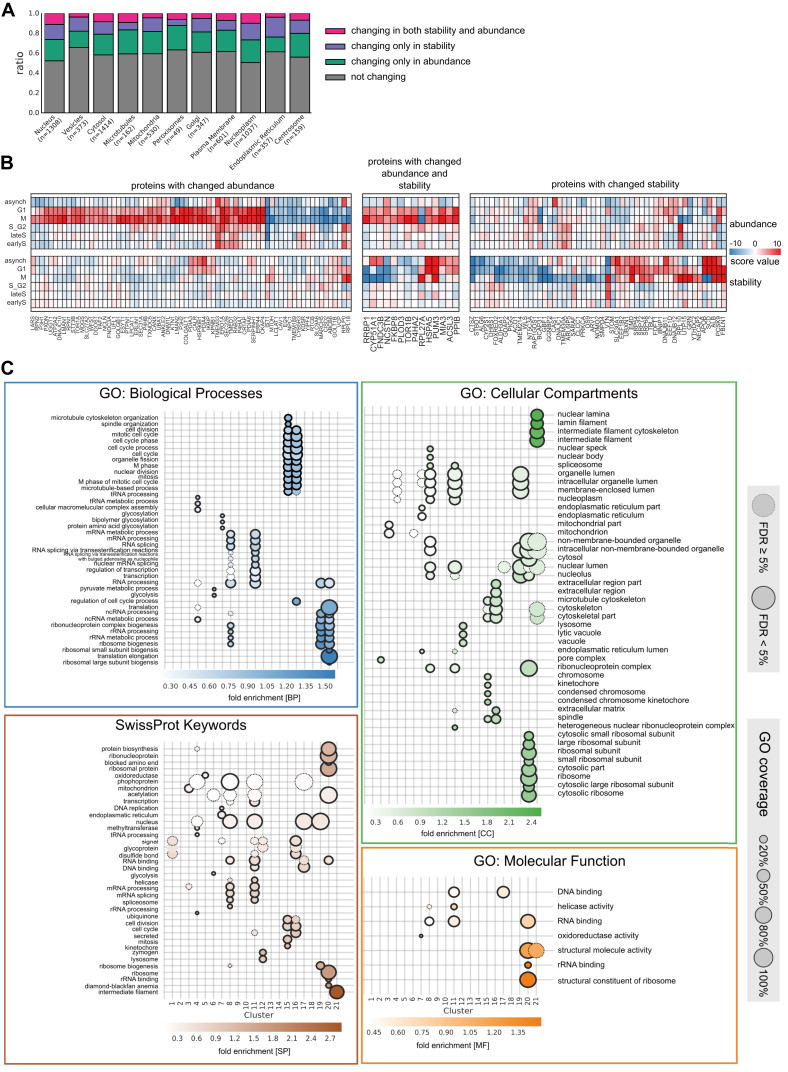
Analysis of Cell-Cycle-Dependent Stability Effects on Organelle-Specific Proteins and Fine-Grained GO Results, Related to Figure 2E(A) Bar plots showing the ratio of organelle-specific proteins (as defined from gene ontology) affected in either stability or abundance or both.(B) Heatmap showing ER-associated/localized proteins that are significantly affected in their abundance (left panel), stability (right panel) or both (middle panel) during mitosis.(C) GO-enrichment results from DAVID (https://david-d.ncifcrf.gov/) with the colors encoding different broad functional categories. The size of the bubble illustrates the relative coverage of the respective GO-category, and the color of the bubbles shows the fold enrichment, x axis with the 21 clusters defined in Figure 2E.